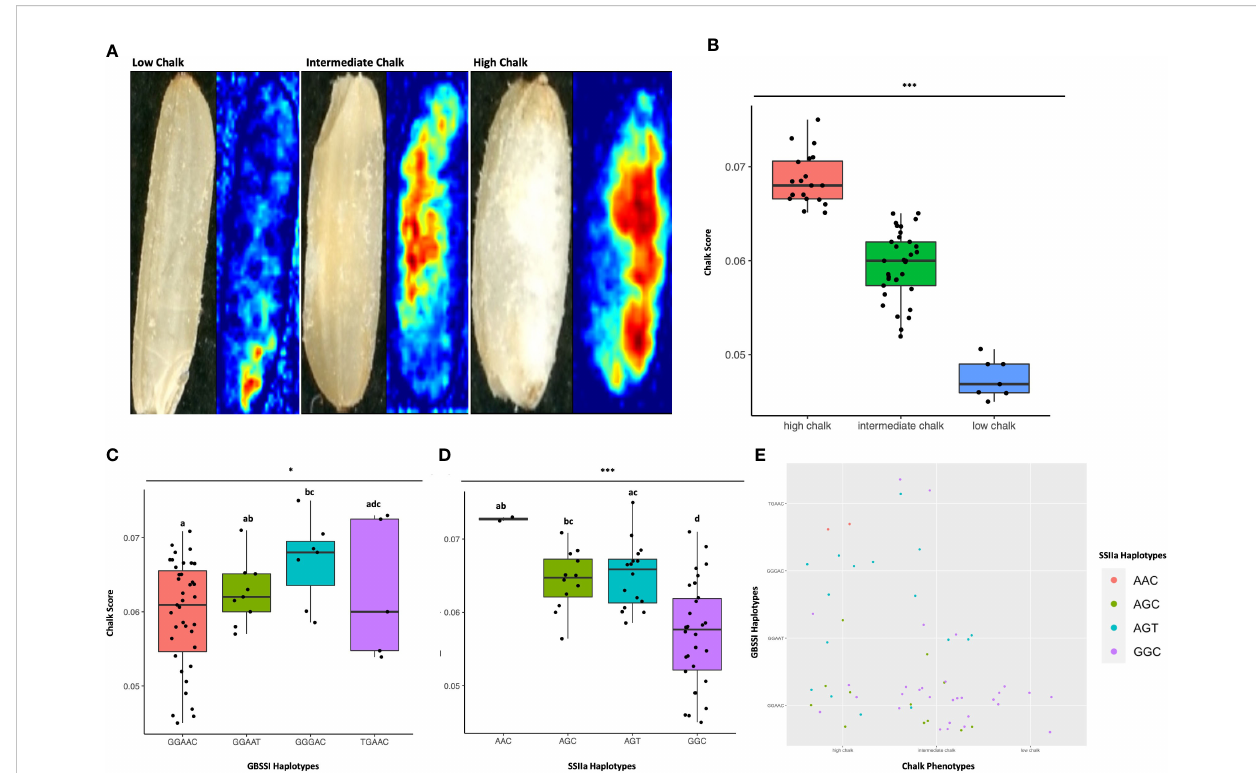
FIGURE 1 Distribution of QTLs and meta-QTLs associated with rice grain chalk on different chromosomes of rice. (A) Trait-wise distribution of initial QTLs used for the meta-QTL analysis. (PGWC, Percentage Grain with Chalkiness; DPGWC, Degree of Percentage Grain with Chalkiness; DC, Degree of Endosperm Chalkiness; ET, Endosperm Transparency; CA, Chalkiness Area; WBe, White Belly; WBa, White Back; WBR, ; WBA, White Back Area; WC, White core; WCR, White core rate; WCA, White core area; MW, Milky white; BW, Basal White; WBB, White Back and Basal) (B) The distribution of QTLs, projected QTLs and meta-QTLs on twelve rice